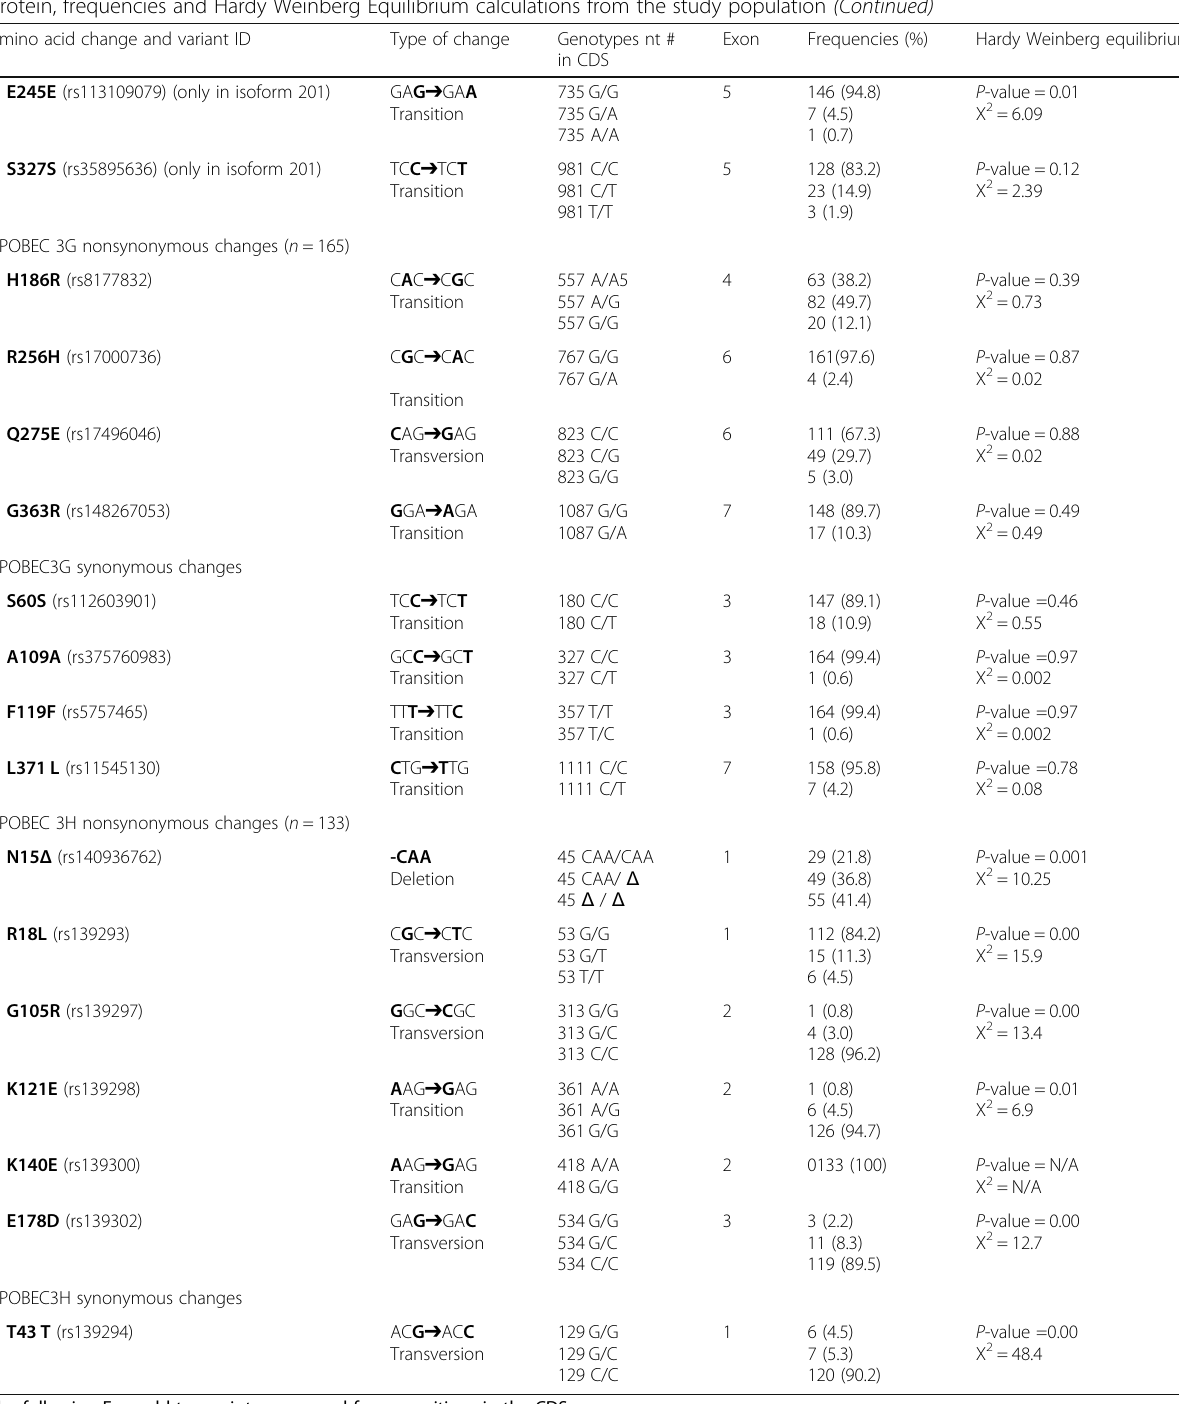
Table 2 APOBEC 3D, 3F, 3G and 3H nonsynonymous and synonymous changes, genotypes, amino acid position and change in the protein, frequencies and Hardy Weinberg Equilibrium calculations from the study population